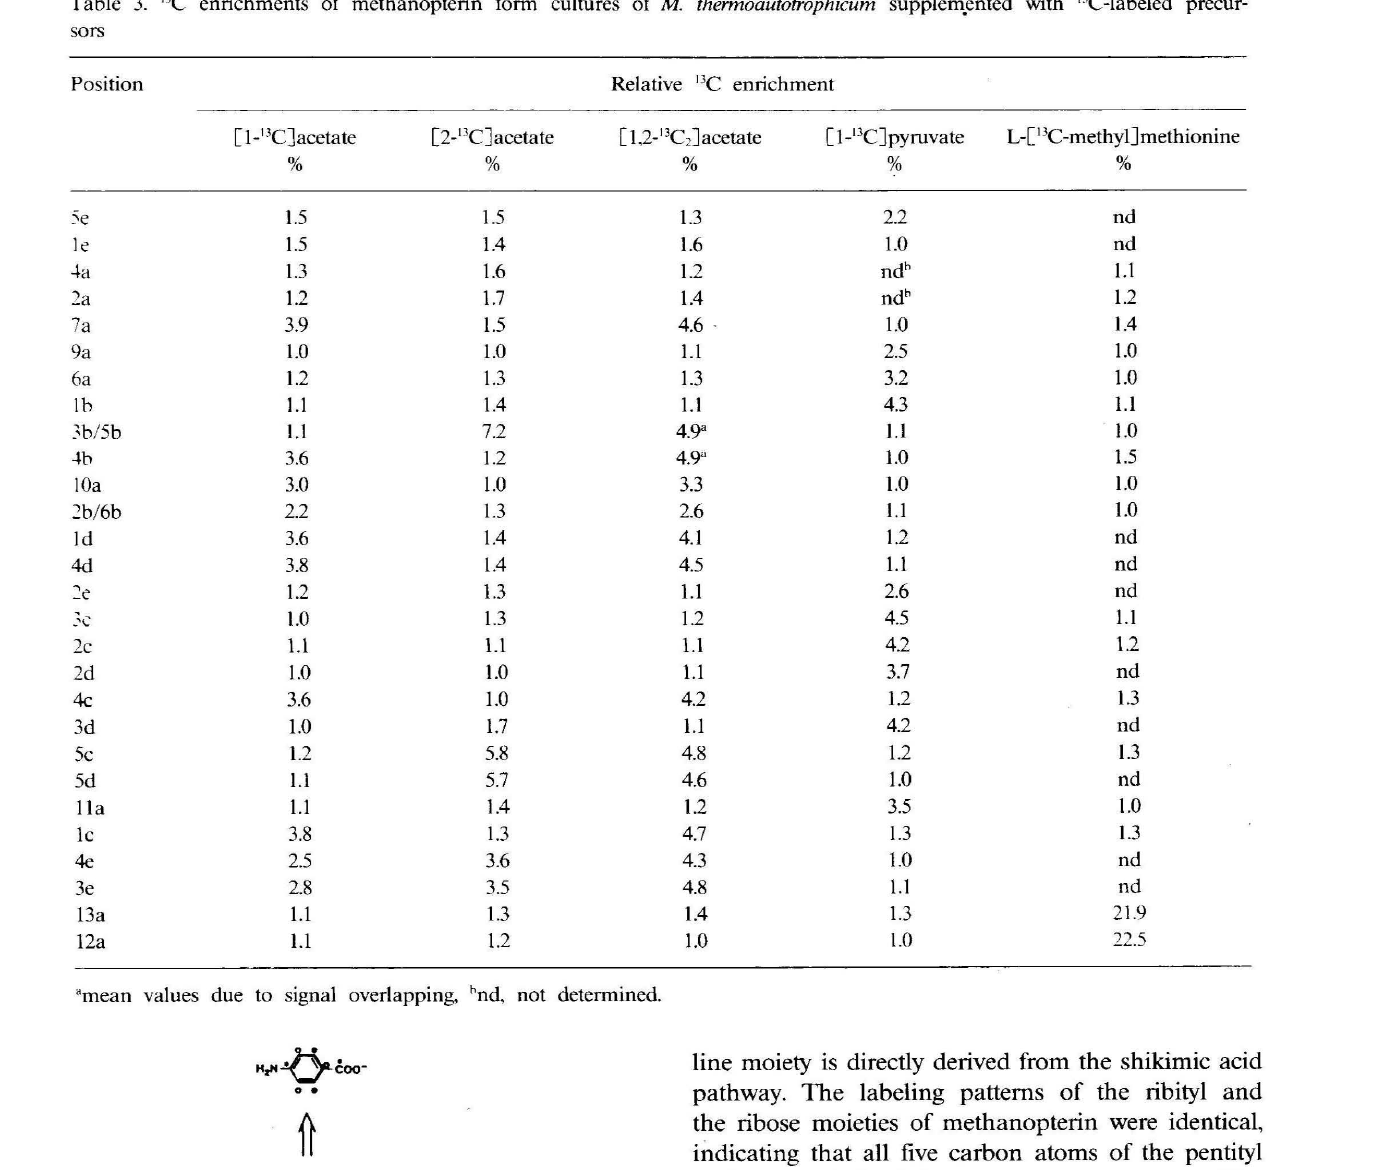
Table 3. "c enrichments of methanopterin form cultures of M. thermoautotrophicum supplem.ented with llC-labeled precur sors